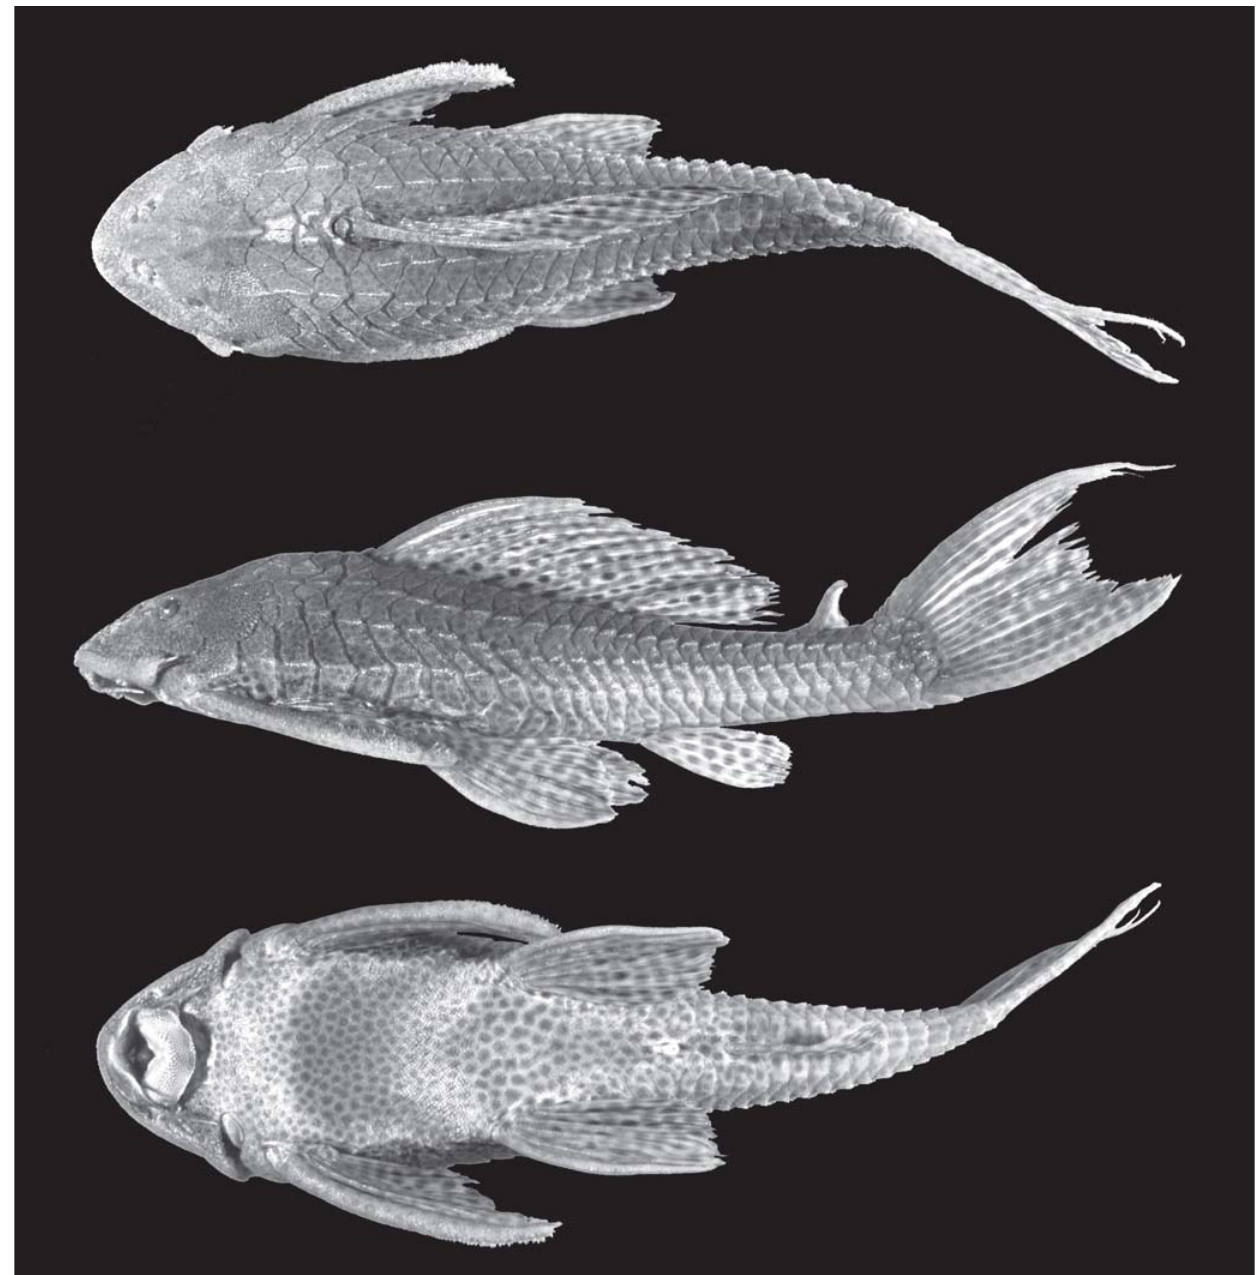
Fig. 2. Dorsal, lateral, and ventral views of Pterygoplichthys punctatus , MCP 35755, 203.1 mm SL. Photos by J.W.